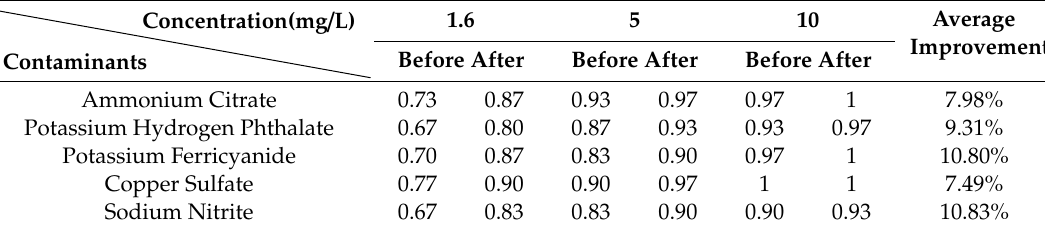
Table 4. Comparison of online classification accuracy of contaminants before and after the fusion of cross-correlation information based on multi-fractal detrended cross-correlation analysis (MF-DCCA).